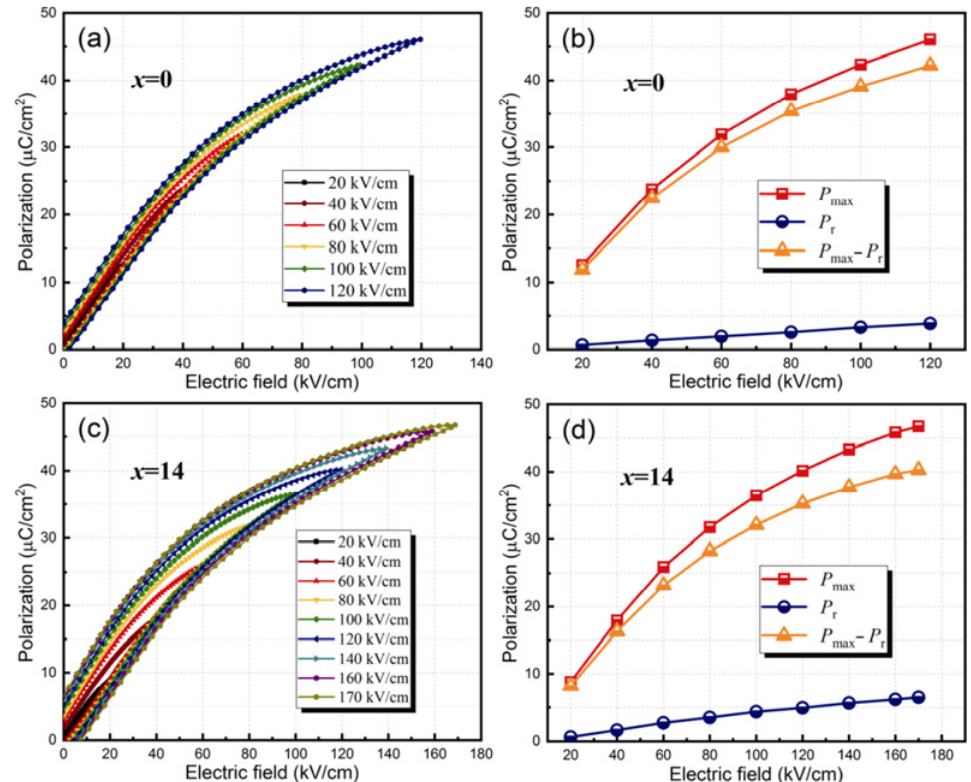
Fig. 7 (a) Unipolar P–E loops and (b) P max , P r , and P max − P r of the BS 0.5 BNT ceramics under different electric fields; (c) unipolar P–E loops and (d) P